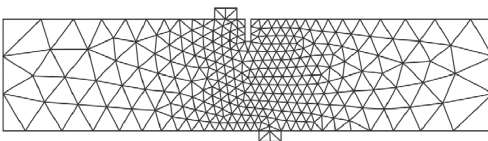
Figure 16: Nonstructured mesh for the beam